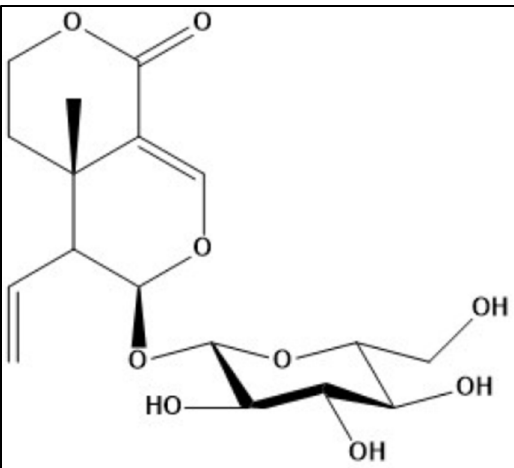
Figure 5. Chemical structure of